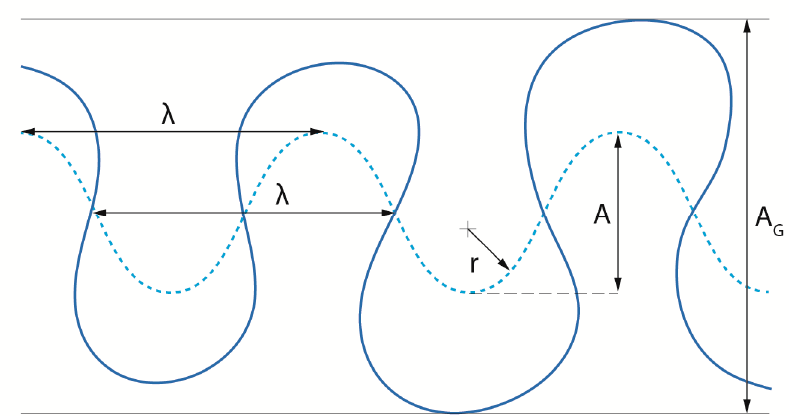
Figure 8. The dotted line represents an idealized river course, the continuous line a meandering river course. λ : meander wavelength, A: meander amplitude, r: meander radius, A G : meander belt © Susanne Rutishauser.